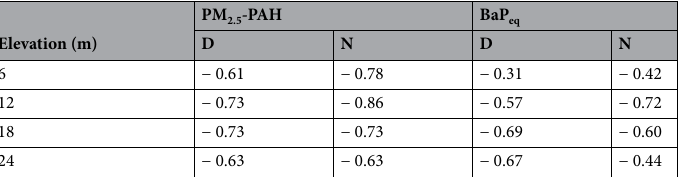
Table 3. Correlation coefficients of the PM 2.5 -associated PAH or BaP eq concentrations and atmospheric temperatures during daytime and nighttime.